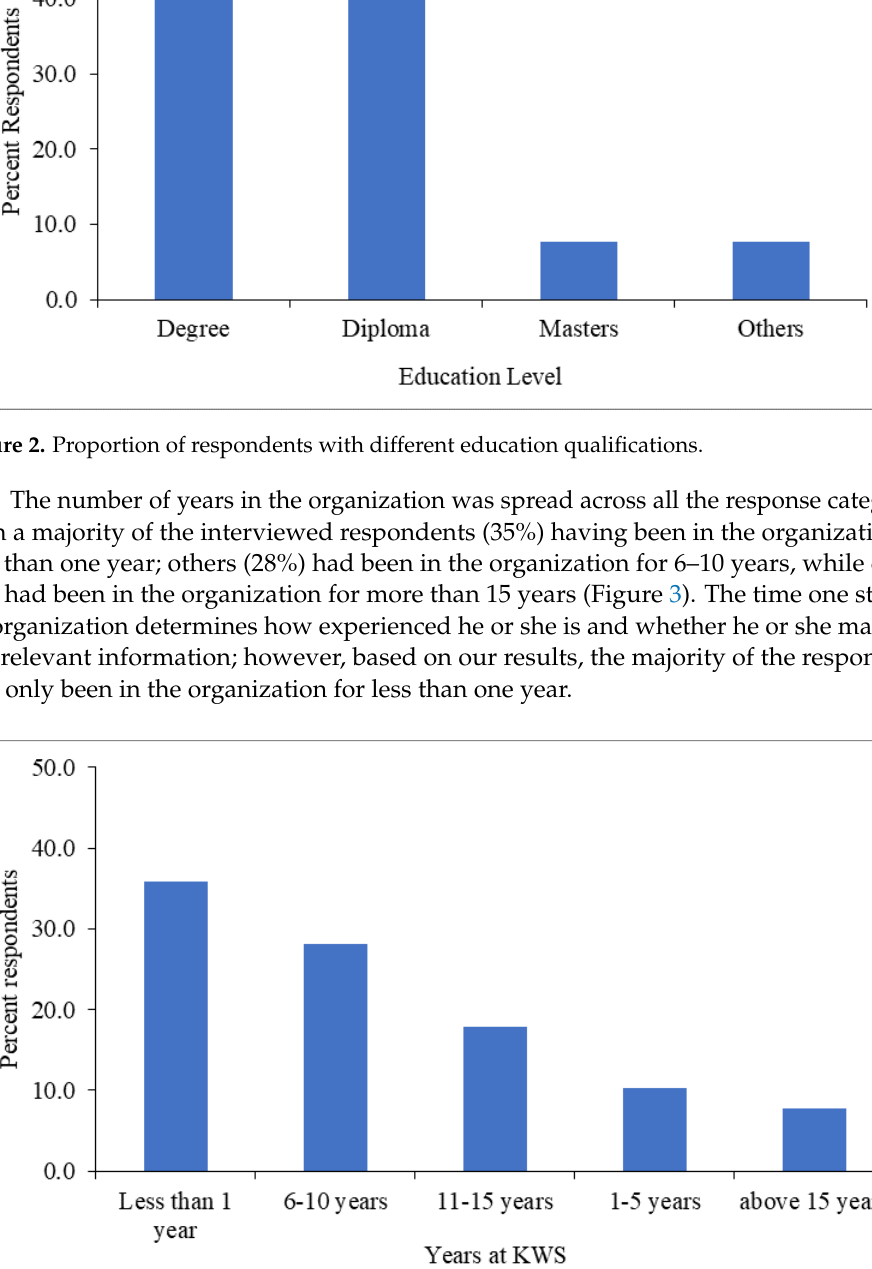
Figure 1. The proportion of the respondents in different age categories.